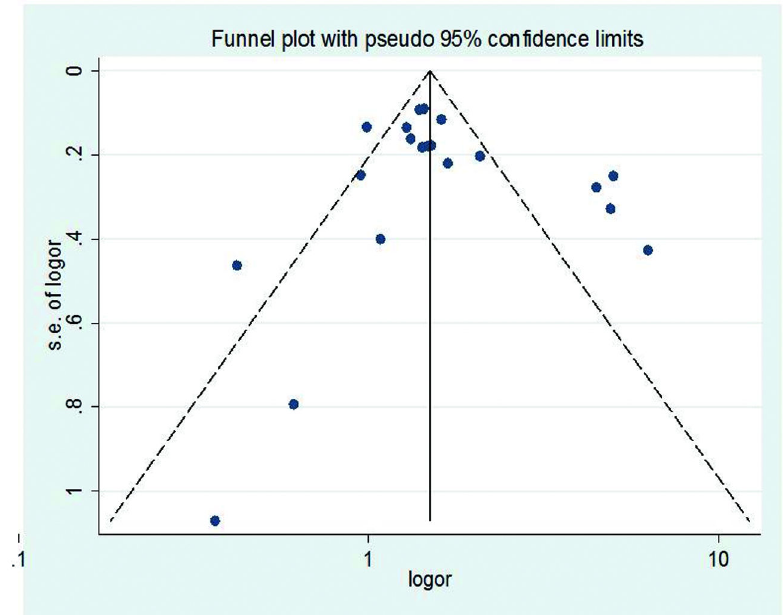
Figure 7. Funnel plot of standard error of log OR over log